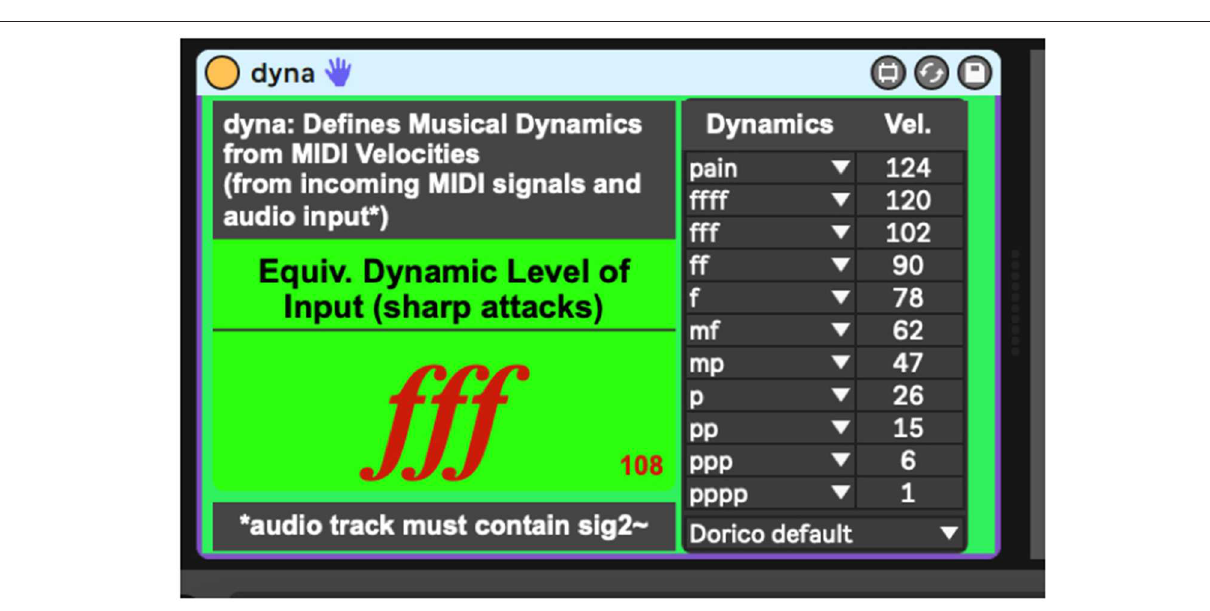
process so a noise bed definition can be made. After